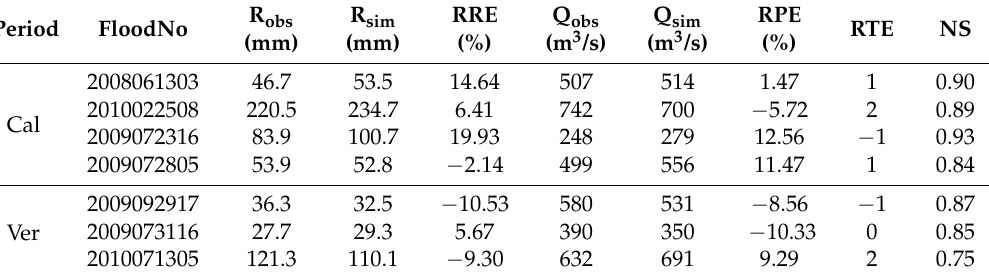
Table 3. Statistics of flood simulations, after the construction of the